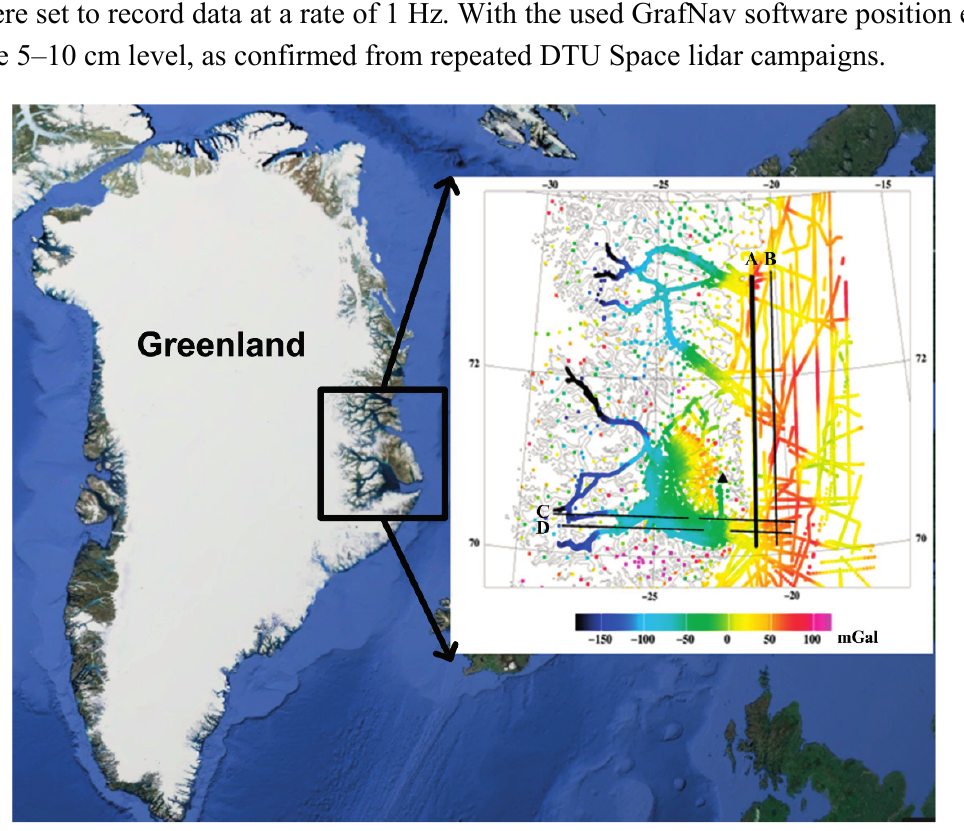
Figure 3. Flight profiles in Greenland test and existing ground, marine and airborne coverage of the region. The four flight profiles shown in black (the primary line A is in bold) were designed in central East Greenland. Breaks in line C and D are due to altitude changes. The colors show the free-air